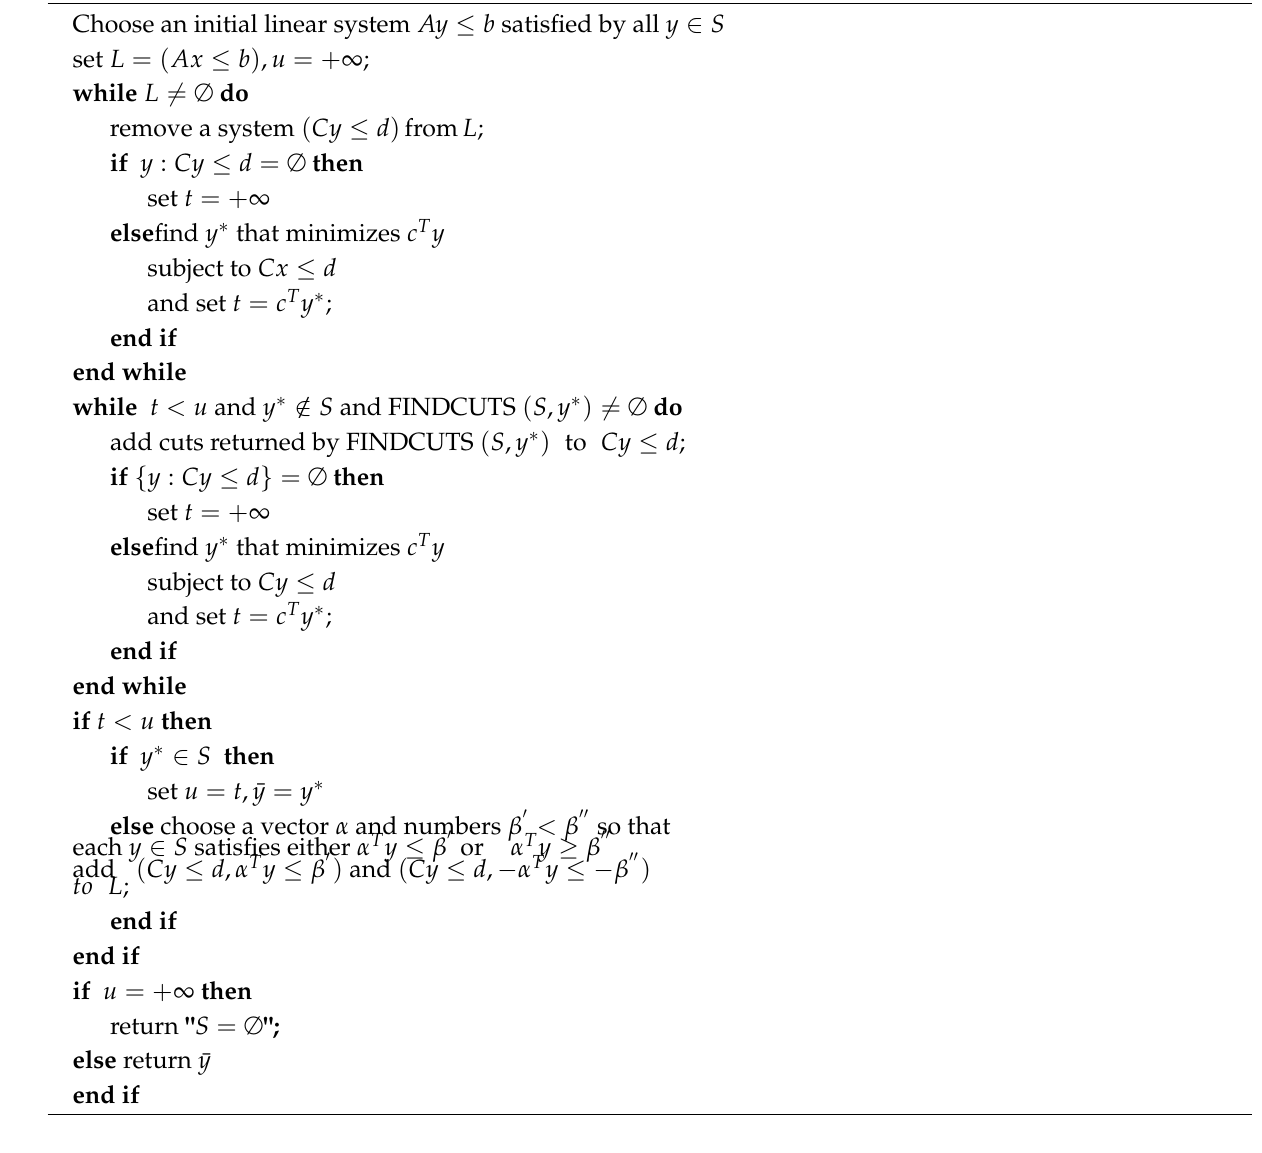
Algorithm 1 Branch and cut